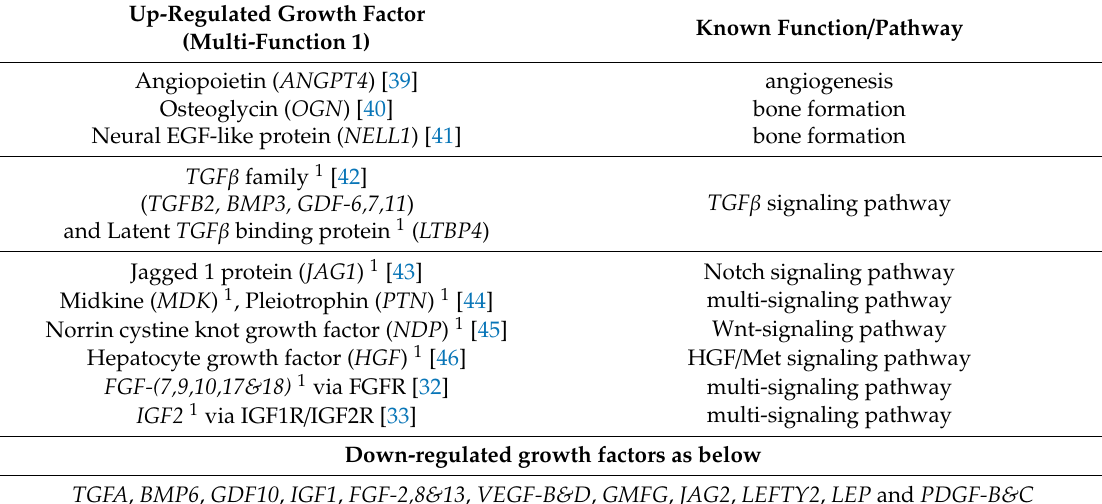
Table 1. Up- and down-regulated growth factors in OAT-H compared to WAT.